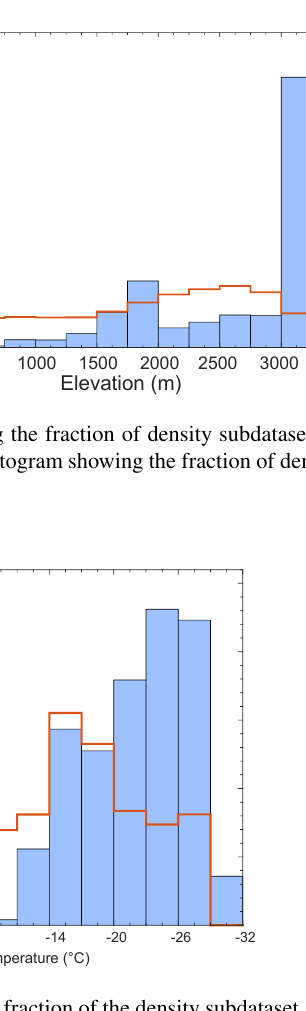
Figure 9. Histogram showing the fraction of the density subdataset by modeled 3m annual air temperature. Red line shows 1990–2015 annual average MAR3.5 model 3m air temperature distribution for each grid cell across the ice